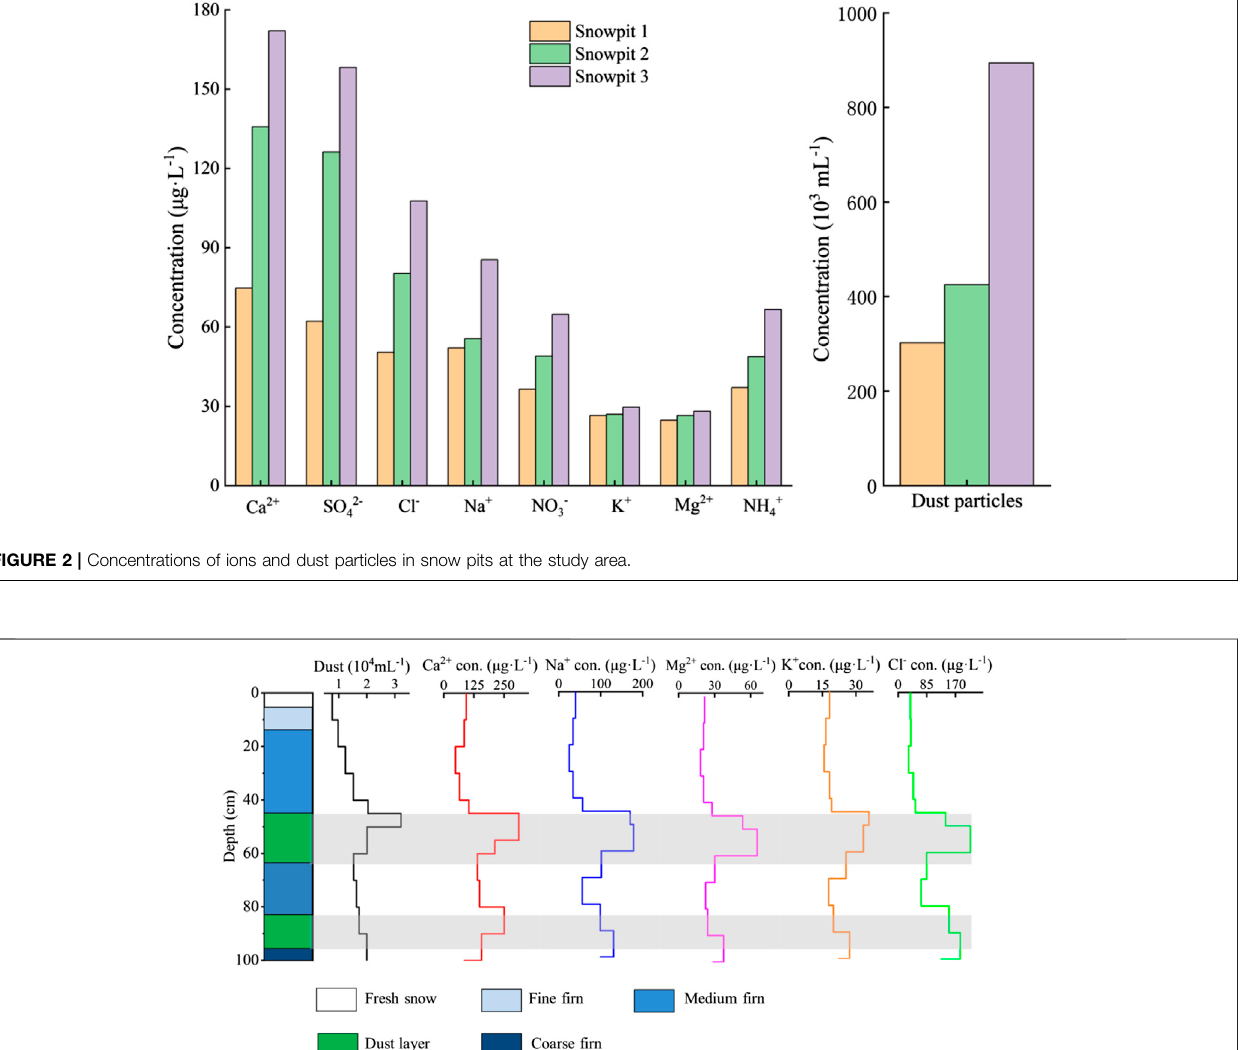
FIGURE 3 | Variations in dust and ions with depth in Snow pit